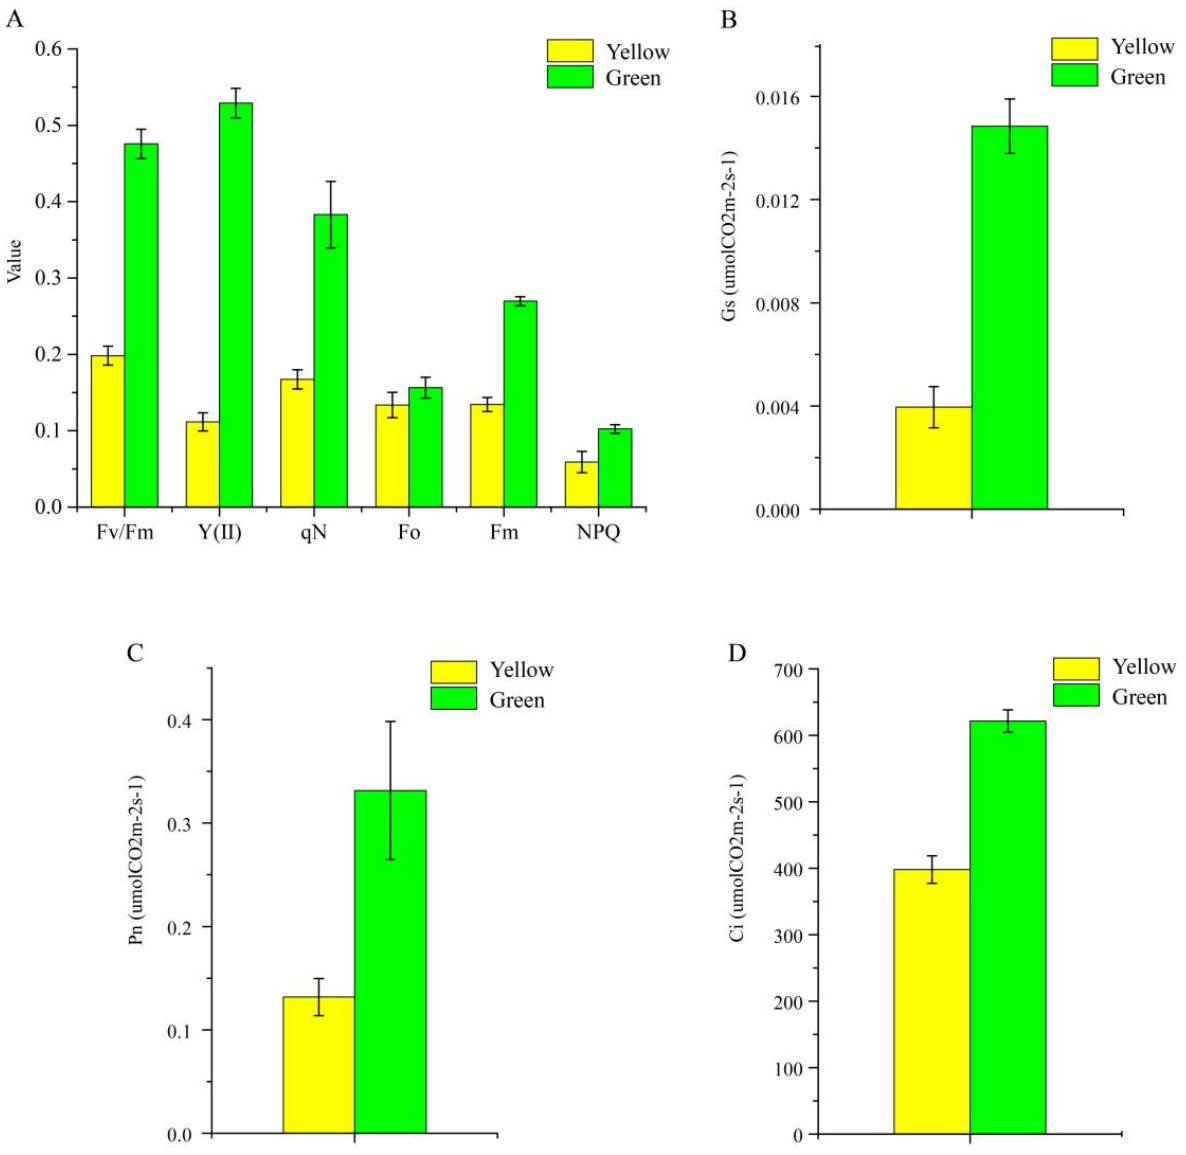
Figure 4. Photosynthetic characteristics ( A ) and three chlorophyll fluorescence parameters ( B – D ) of P. SCBG COP15 and the yellow mutant.